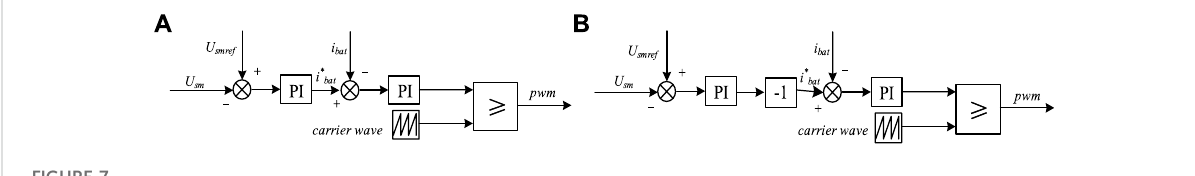
FIGURE 6 MMC-CLES main control system.